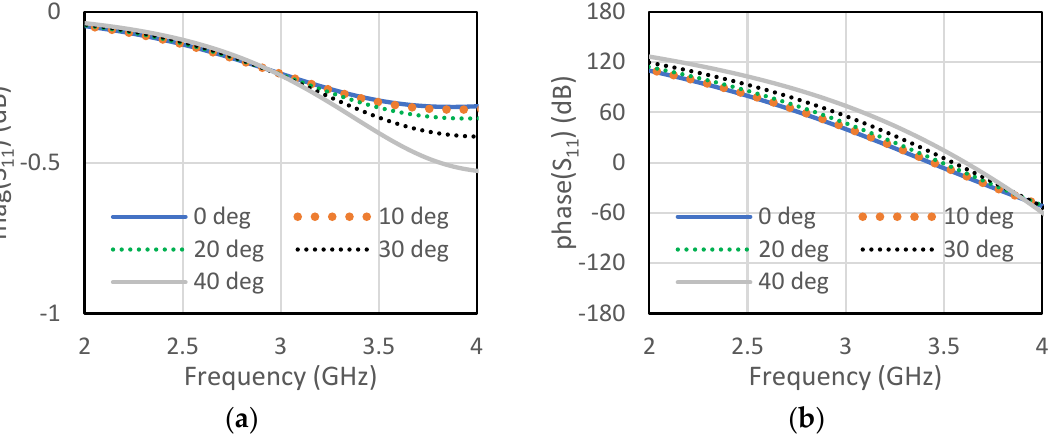
Figure 4. Circular type of patch ( a ) magnitude of S 11 for different angles of incidence ( b ) phase of S 11 for different angles of incidence.